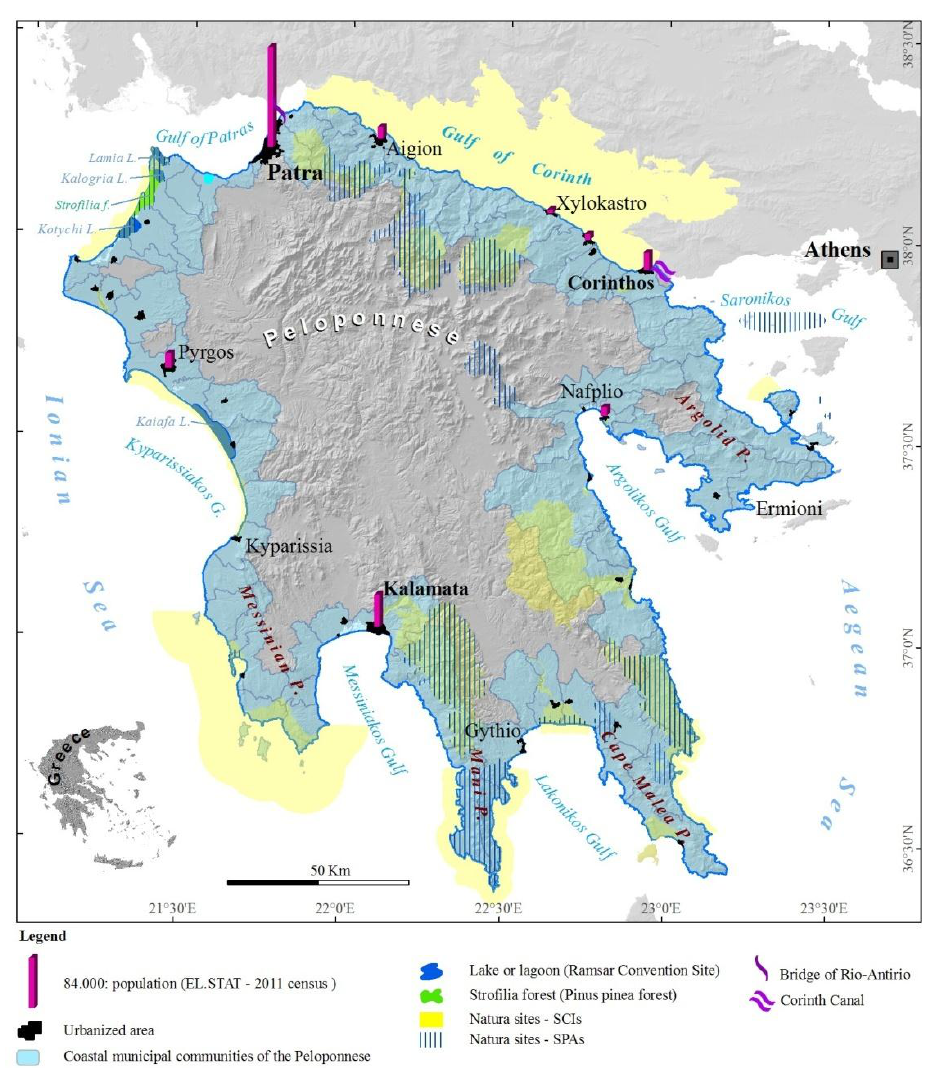
Figure 1. Hill-shaded map of the Peloponnese. The map also shows the 73 coastal municipal communities of the study area.